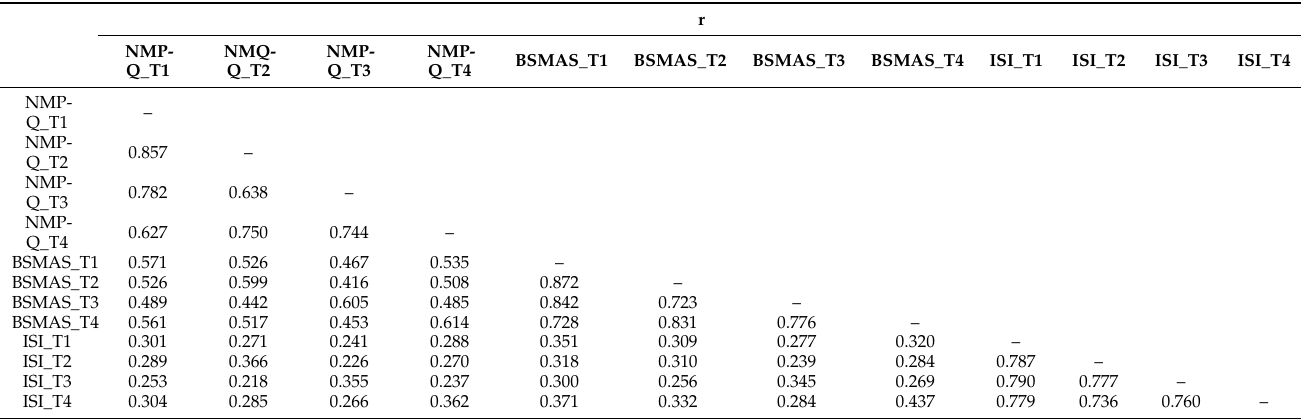
Table 3. Correlation matrix among nomophobia, addictive use of social media, and insomnia across time.